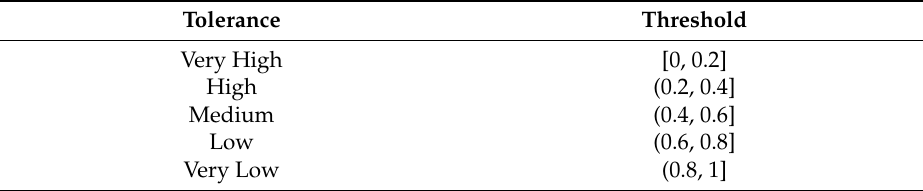
Table 2. Relationship between the degree of private information leakage and threshold